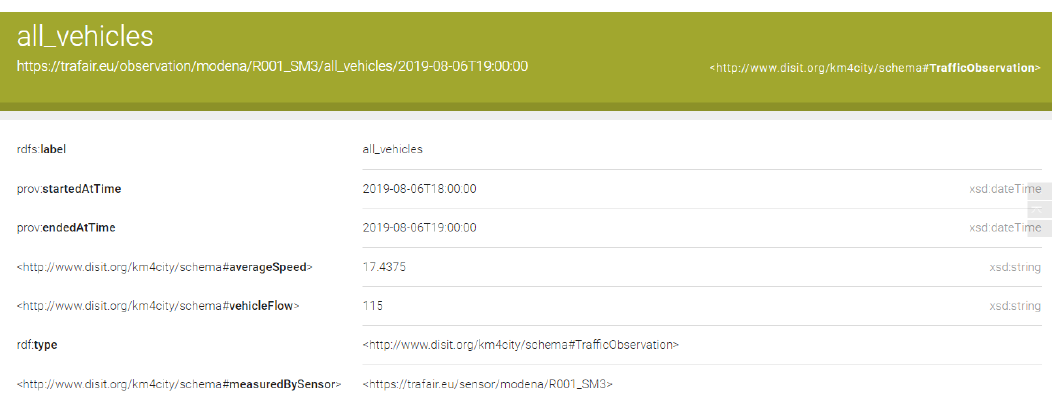
Figure 9. LodView representation of the station information of the traffic sensor “R001_SM3”.